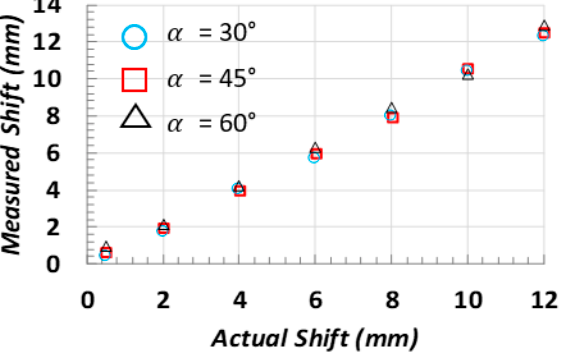
Figure 6. Obtained measurements applying the proposed model as a function of the translational shift extent and the angle between the camera and the sensor boss planes ( 𝑏 = 5 cm and 𝑍 (cid:2868) = 48 cm).